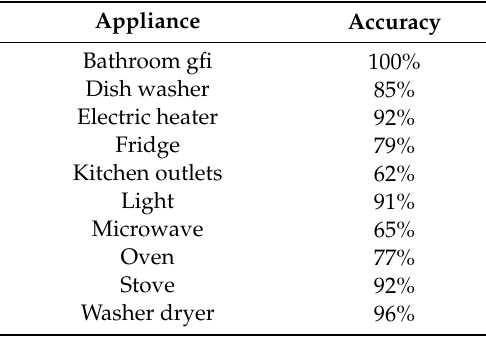
Table 4. Status recognition